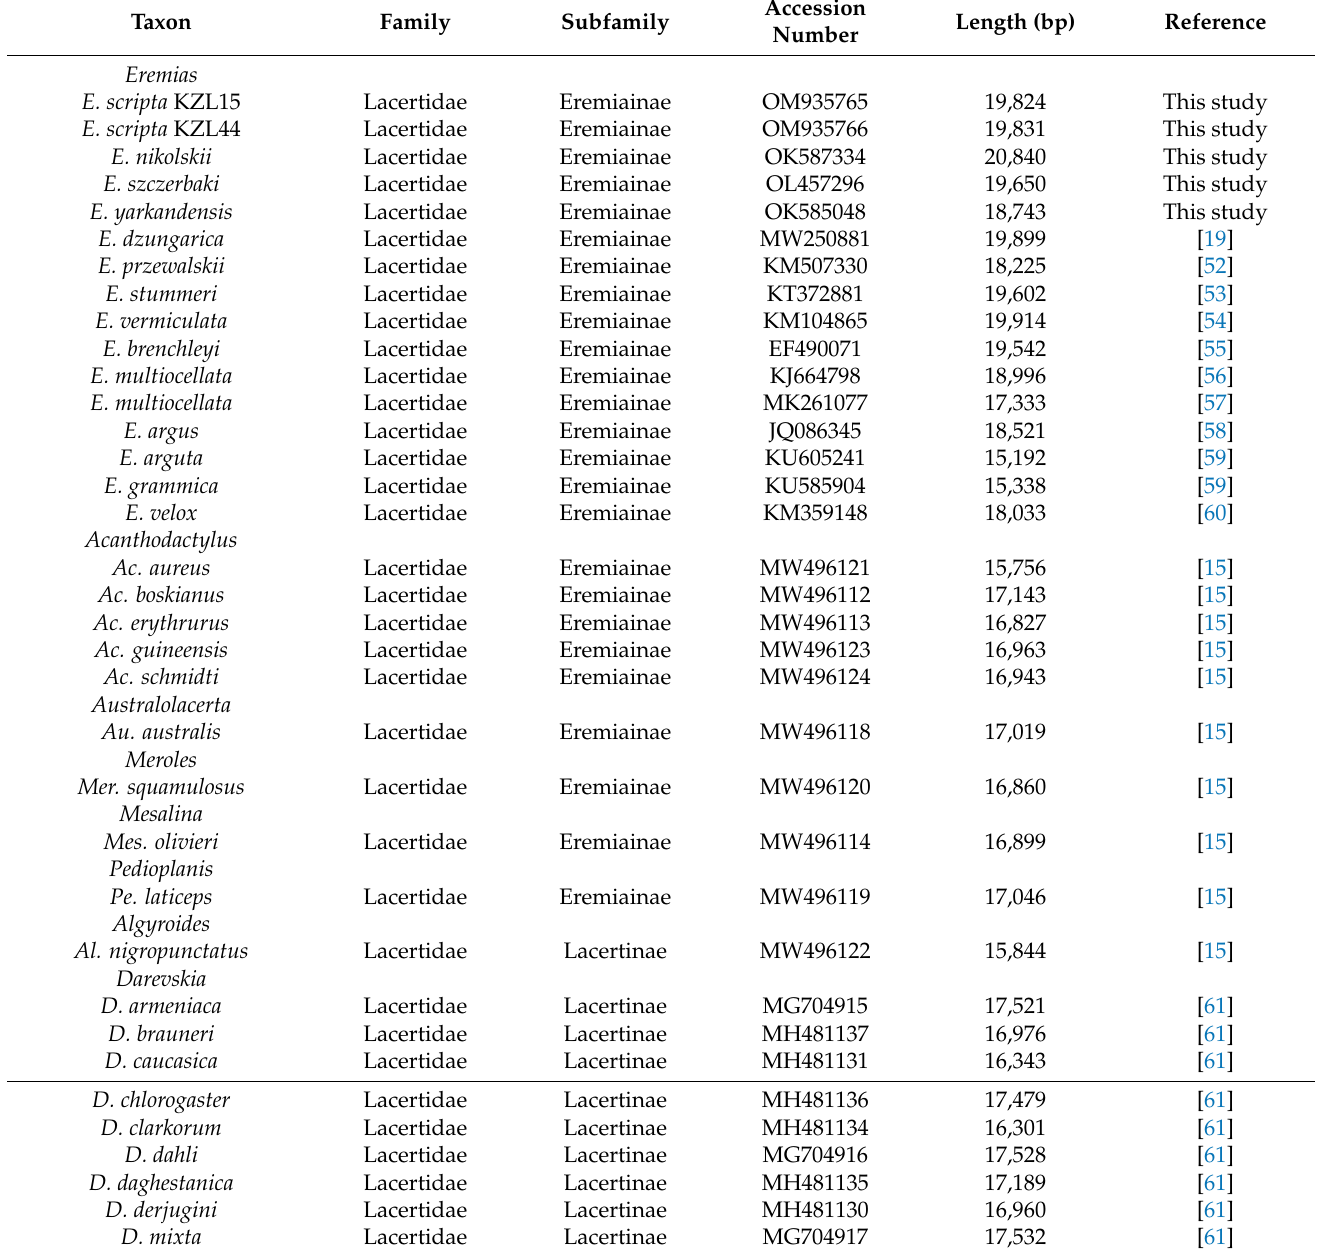
Table 2. Taxon information of Lacertidae and three outgroup species analyzed in this paper with GenBank accession